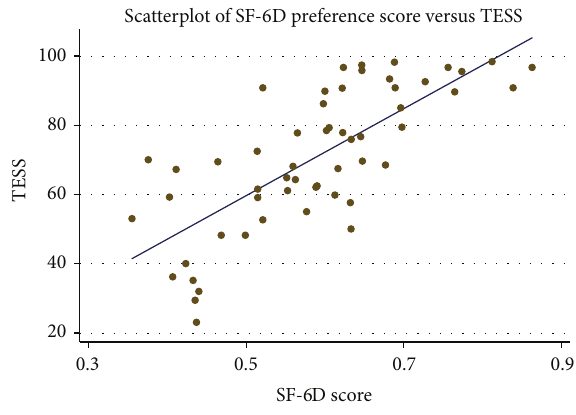
Figure 2: Plot of SF-6D preference scores versus TESS, with linear regression ( 𝑟 = 0.75 , 𝑃 < 0.01 ). TESS: Toronto Extremity Salvage